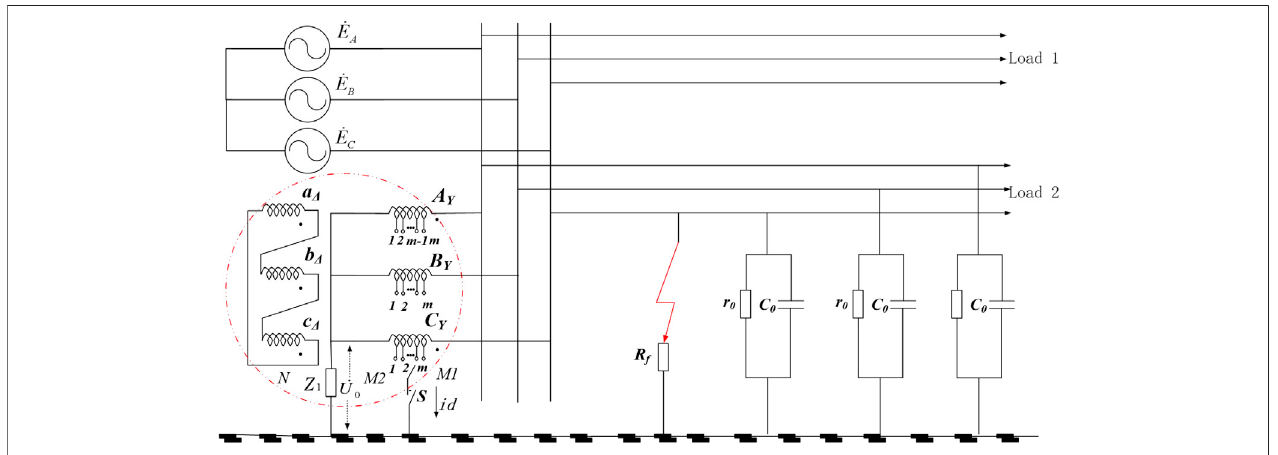
FIGURE 1 | Principle diagram of voltage arc suppression with fl exible control of neutral point potential of the grounding